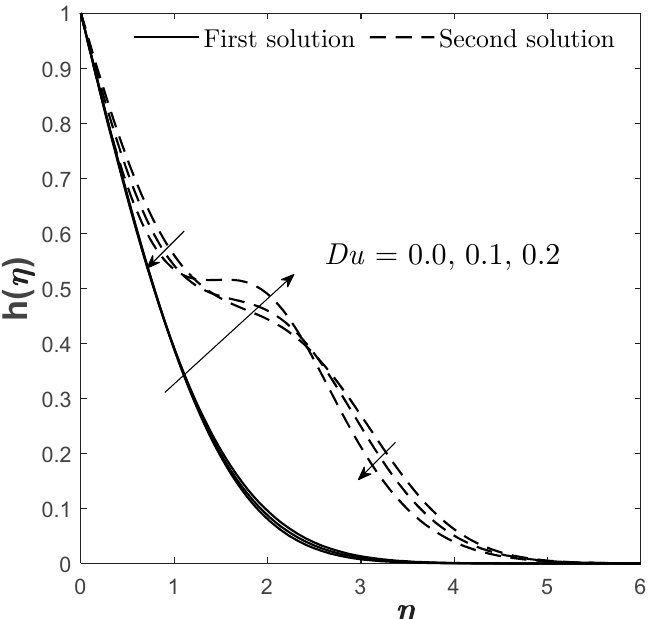
Figure 16. Plots of h ( η ) for varied Du when N = Rd = Sc = Sr = 1, λ = − 1, φ 2 = 0.01, and Bi = 0.1.